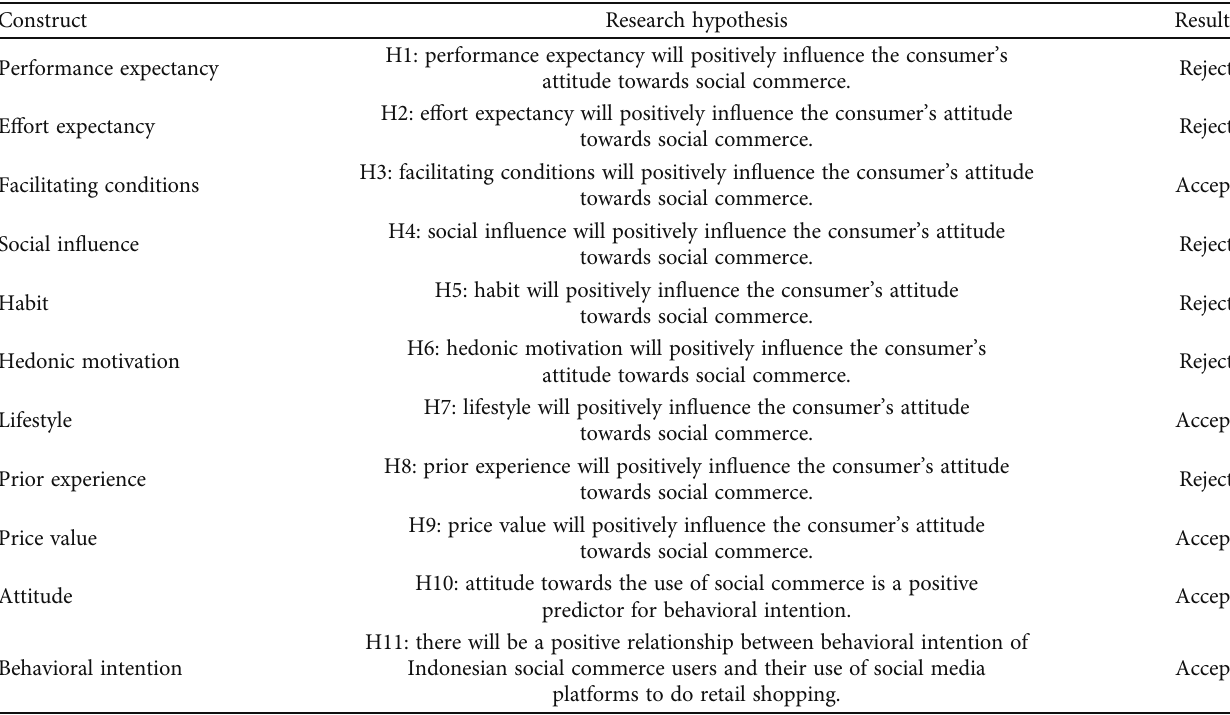
Table 10: Summary of testing results based on the structural